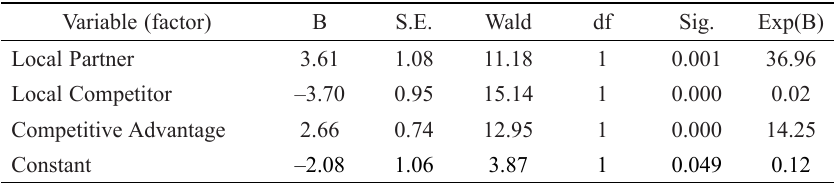
Table 6. Variables in multi-factor logistic